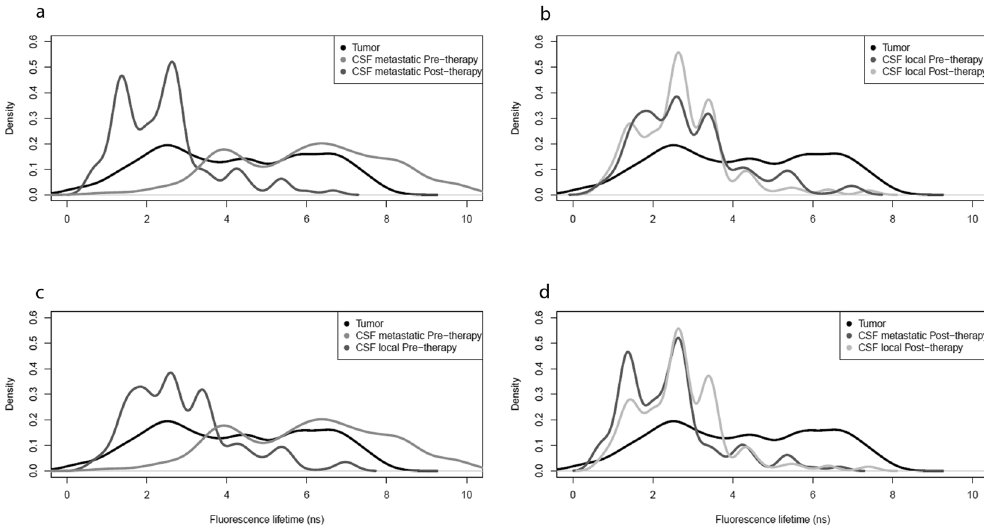
Figure 3. Density plots of fluorescence lifetime findings in tumour cells and CSF cells from patients with ( a ) metastatic disease, ( b ) localised disease ( c ), before chemo/radiotherapy ( d ), after